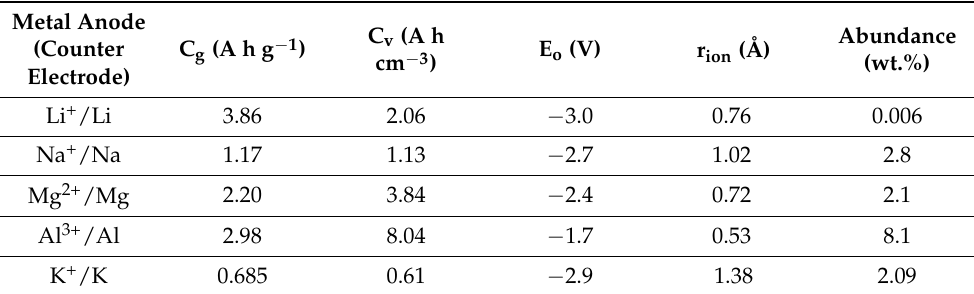
Table 2. Comparison of C g and C v , standard redox potential (E o vs. SHE), ionic radius (r ion ), and abundance in the Earth’s crust of various metal anodes [67].